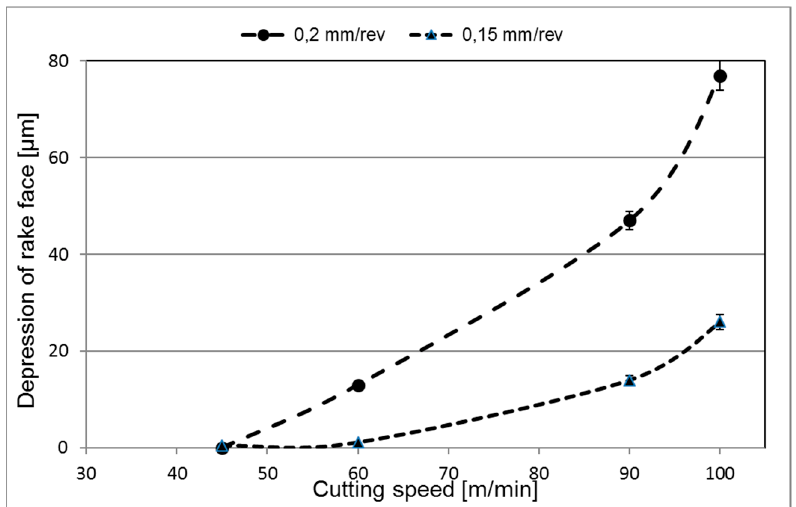
Figure 11. Depression of the rake face in connection to the cutting edge as a function of cutting speed and cutting feed. Time: 3 min.